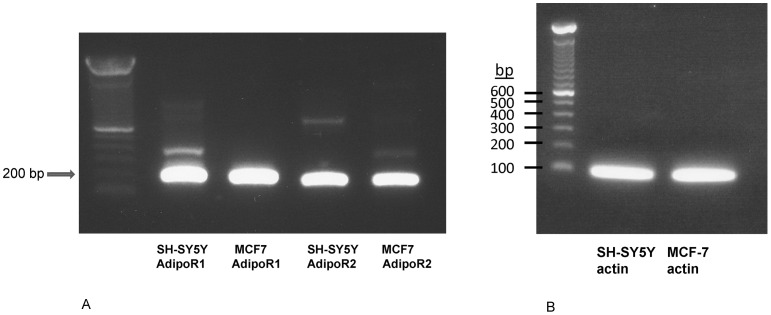
Human neuroblastoma cells (SH-SY5Ycells) express both adiponectin receptor 1 and 2.
A. Reverse transcriptase polymerase chain reaction (RT-PCR) for expression of adiponectin receptor 1 (AdipoR1) and 2 (AdipoR2) in human neuroblastoma cells (SH-SY5Ycells). RT-PCR revealed the presence of PCR products of ∼200 base pair (bp) corresponding to the presence of messenger RNA for AdipoR 1 and 2. MCF7 cells serve as the positive control cells which express both AdipoR 1 and AdipoR 2. B. Actin serve as the housekeeping gene and is expressed by both SH-SY5Y and MCF-7 cells (PCR product of 78 bp). Experiments were performed twice with consistent results.